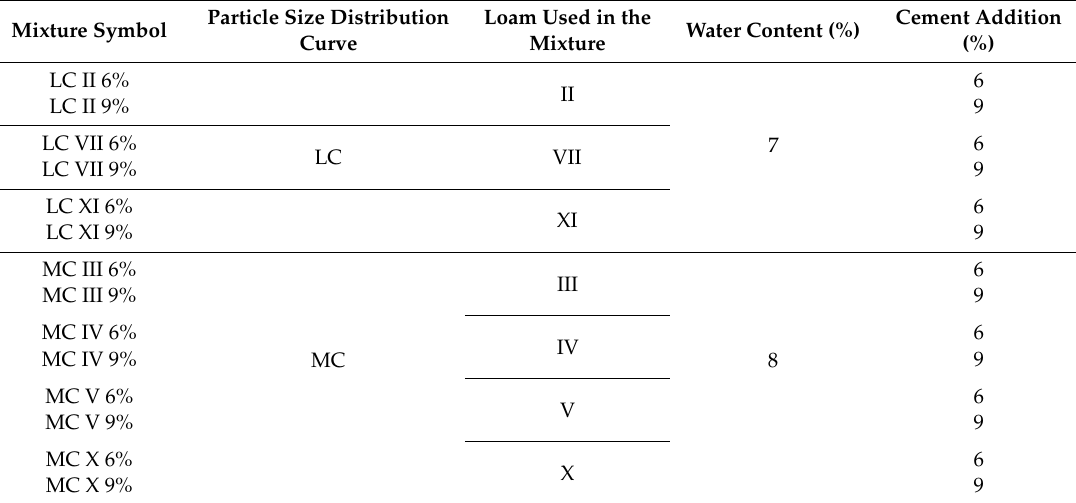
Table 4. List of mixtures from which CSRE samples were